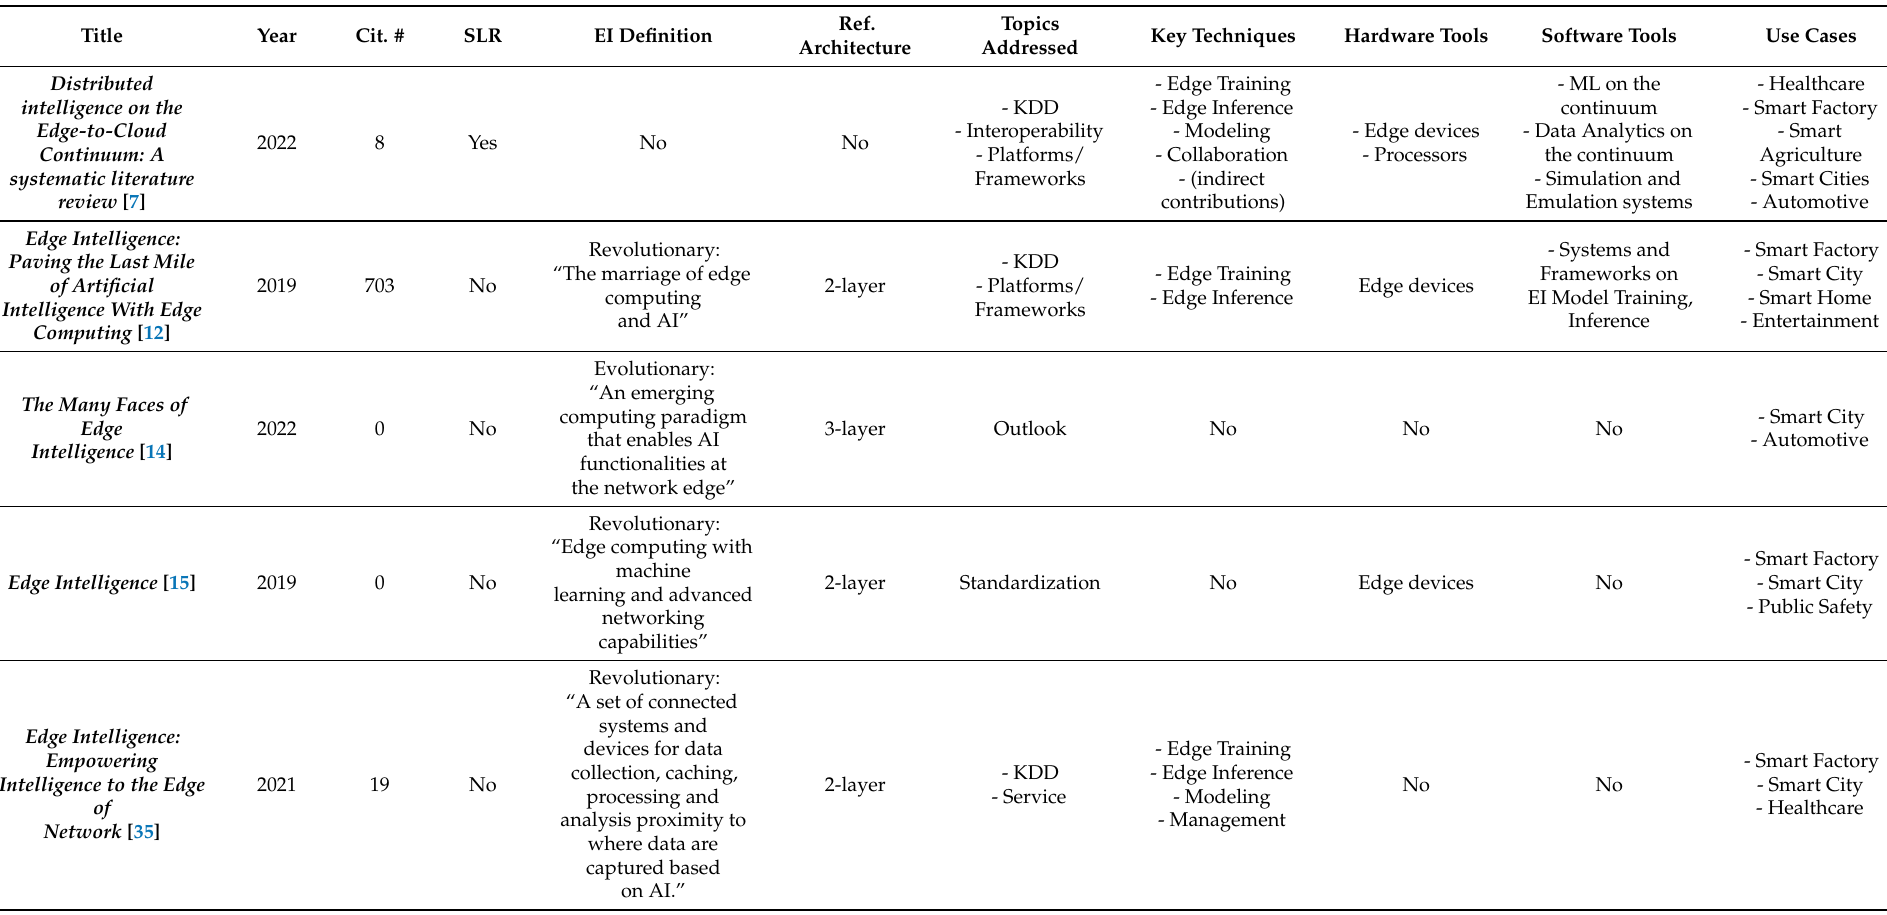
Table 2. Comparison framework for the analyzed